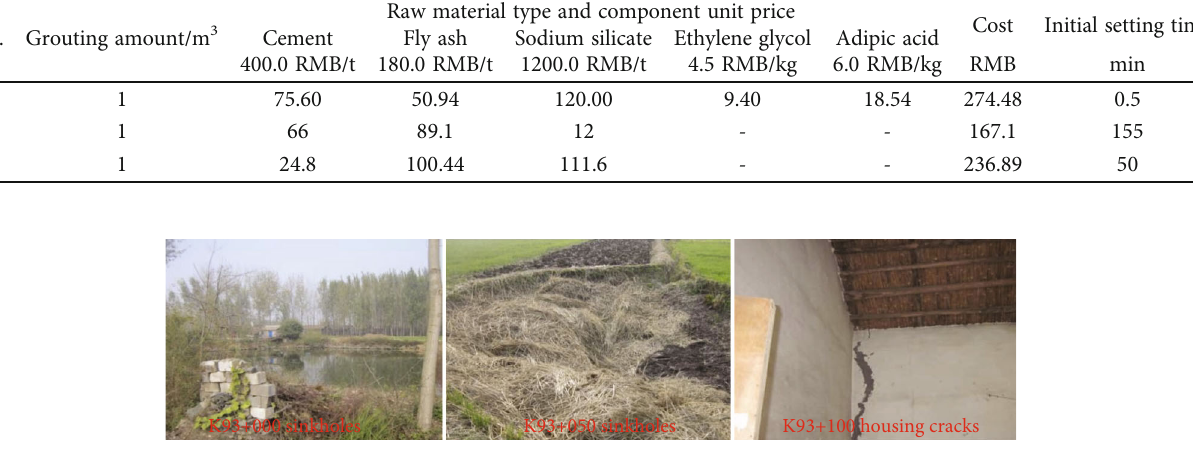
Figure 11: Ground collapse caused by goaf.